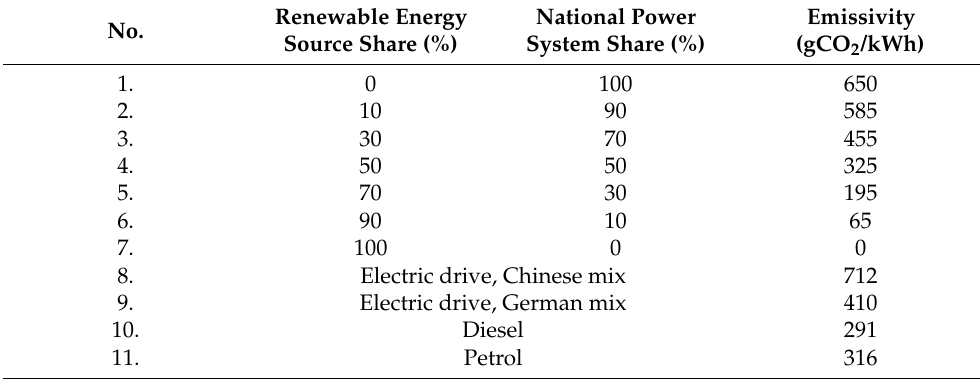
Table 3. Emissions for energy production for different shares of RES in polish National Power System